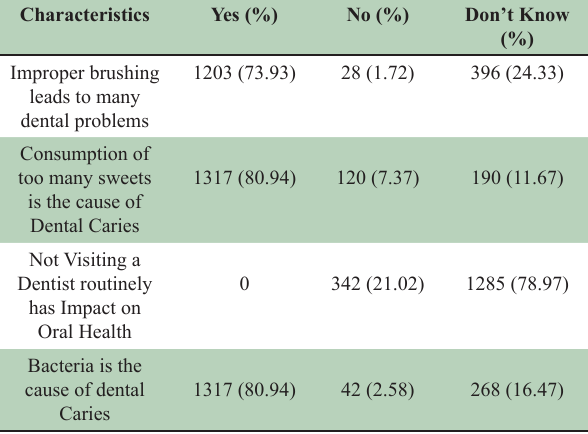
Table-II: Fundamental Knowledge of Dental Caries.